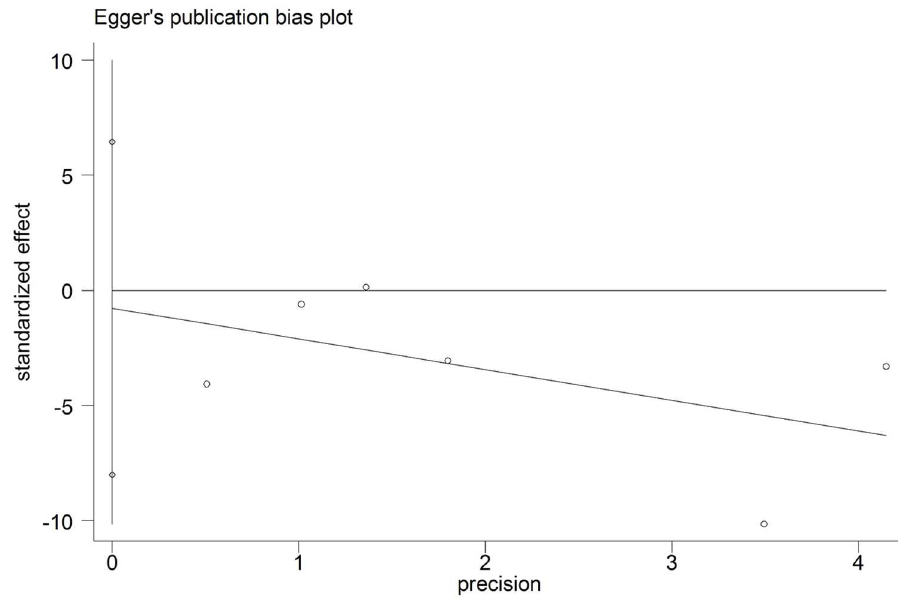
Fig 8. Egger test results of studies on hospital